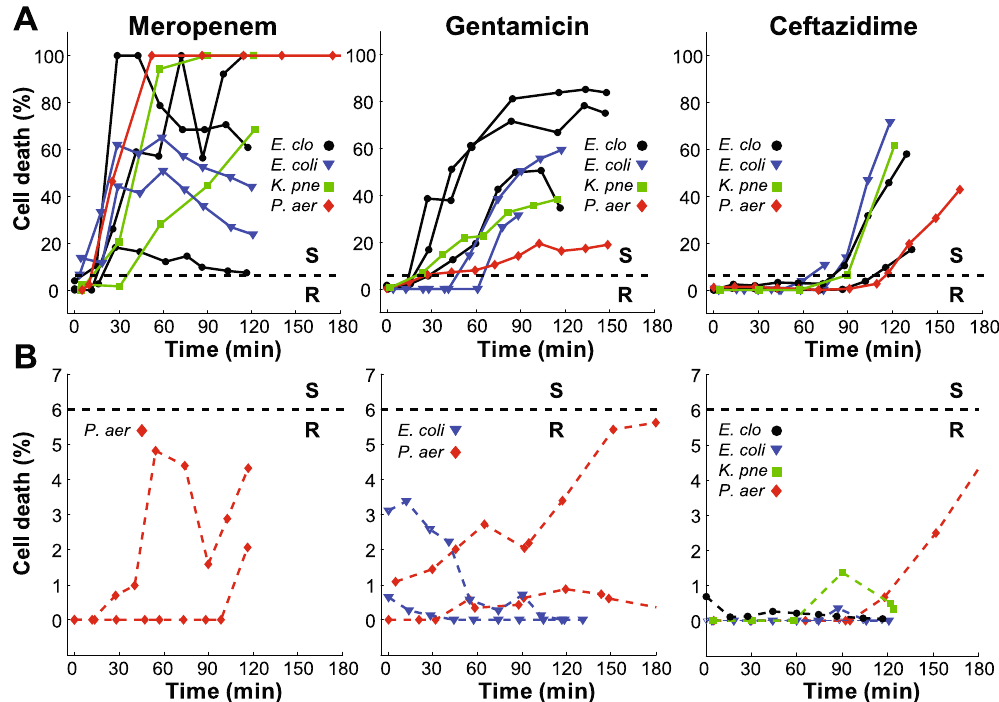
Figure 4. Cell death responses for each Gram-negative strain against different antibiotics. ( A ) Susceptible strains. One experiment per strain shown. The 6% susceptibility threshold is designated with a black line. ( B ) Resistant strains. One representative experiment per strain